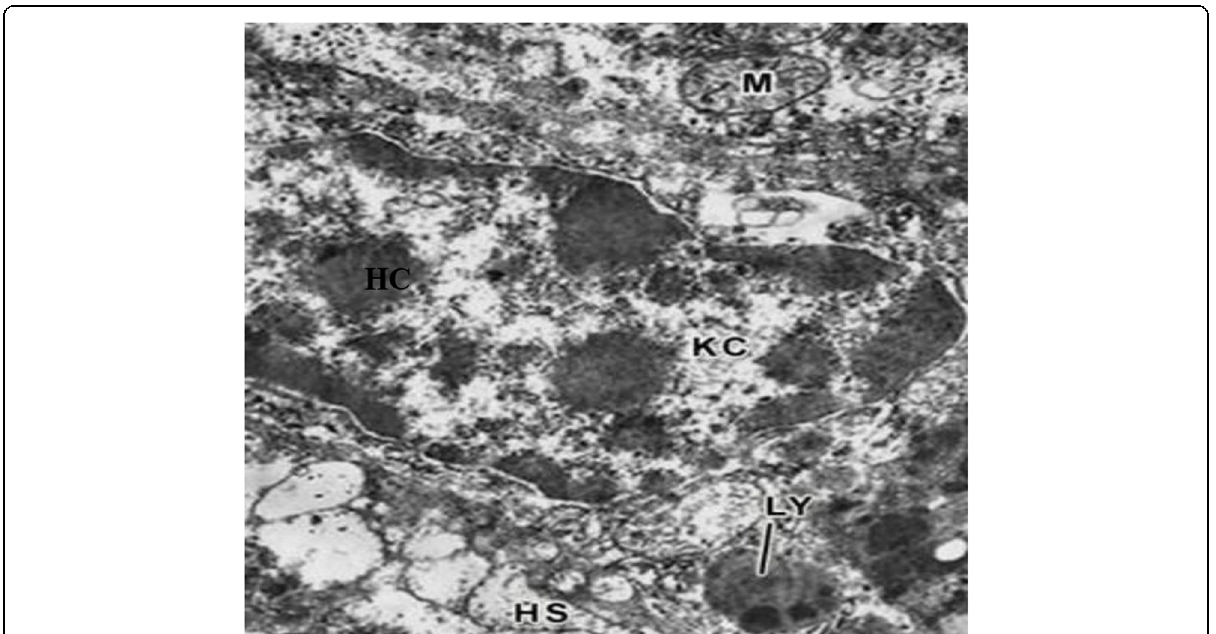
Fig. 13 An electron micrograph of a hepatocyte illustrating the normal manifested phagocytic Kupffer cell (KC) having clumps of heterochromatin (HC) and facing lumen of the hepatic sinusoid (HS). Lysosomes (LY) which vary in density, shape, and size are also seen in the cytoplasm of Kupffer cell. (× 16,000)